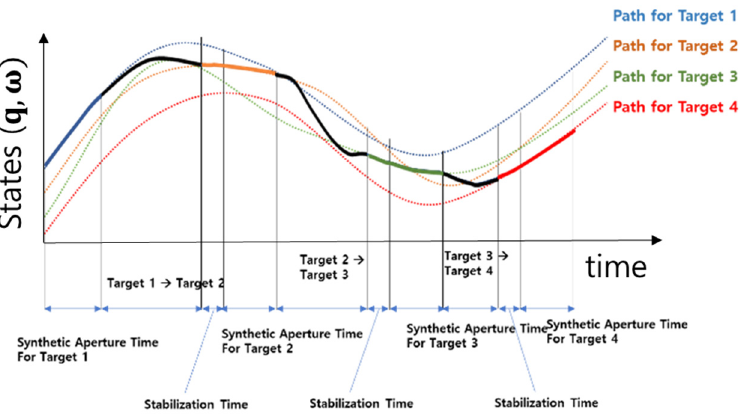
Figure 14. Maneuvering simulation scenario.